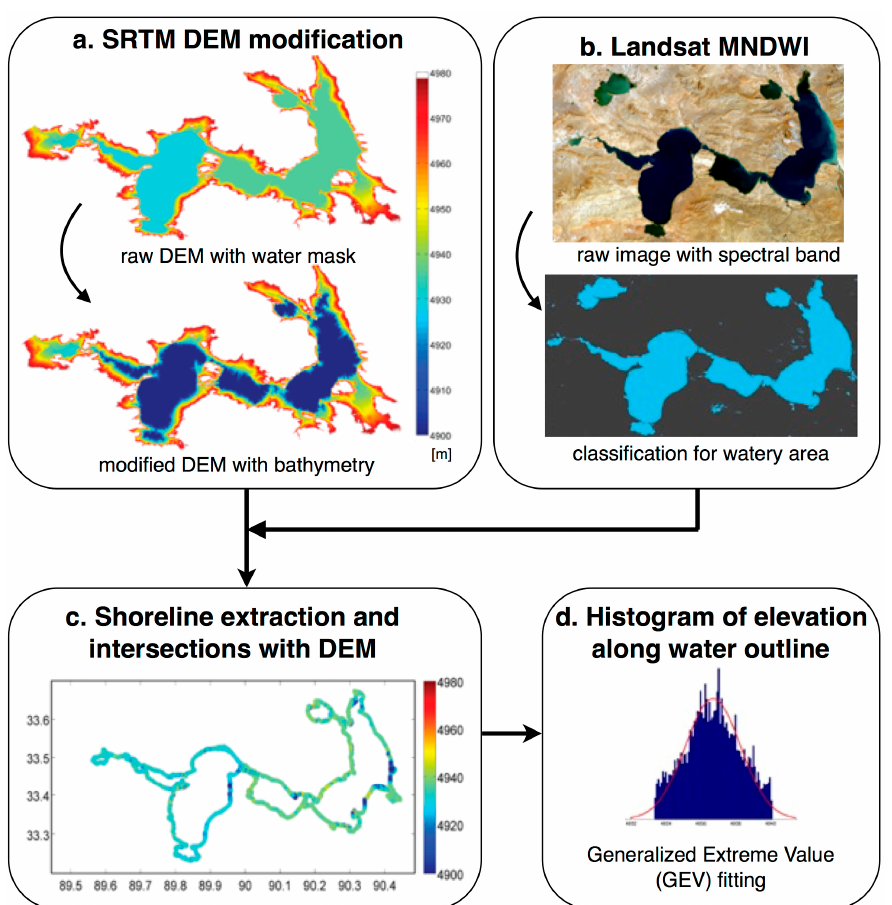
Figure 2. Workflow of TIAS at study site. ( a ) Modify raw SRTM DEM and fill in simulated lake bathymetry; ( b ) compute MNDWI from Landsat bands and use a threshold to separate water/non-water pixels; ( c ) extract water body outline and intersect with modified DEM to obtain height information; and ( d ) use Generalized Extreme Value fitting function of find the maximum likelihood estimate of height.